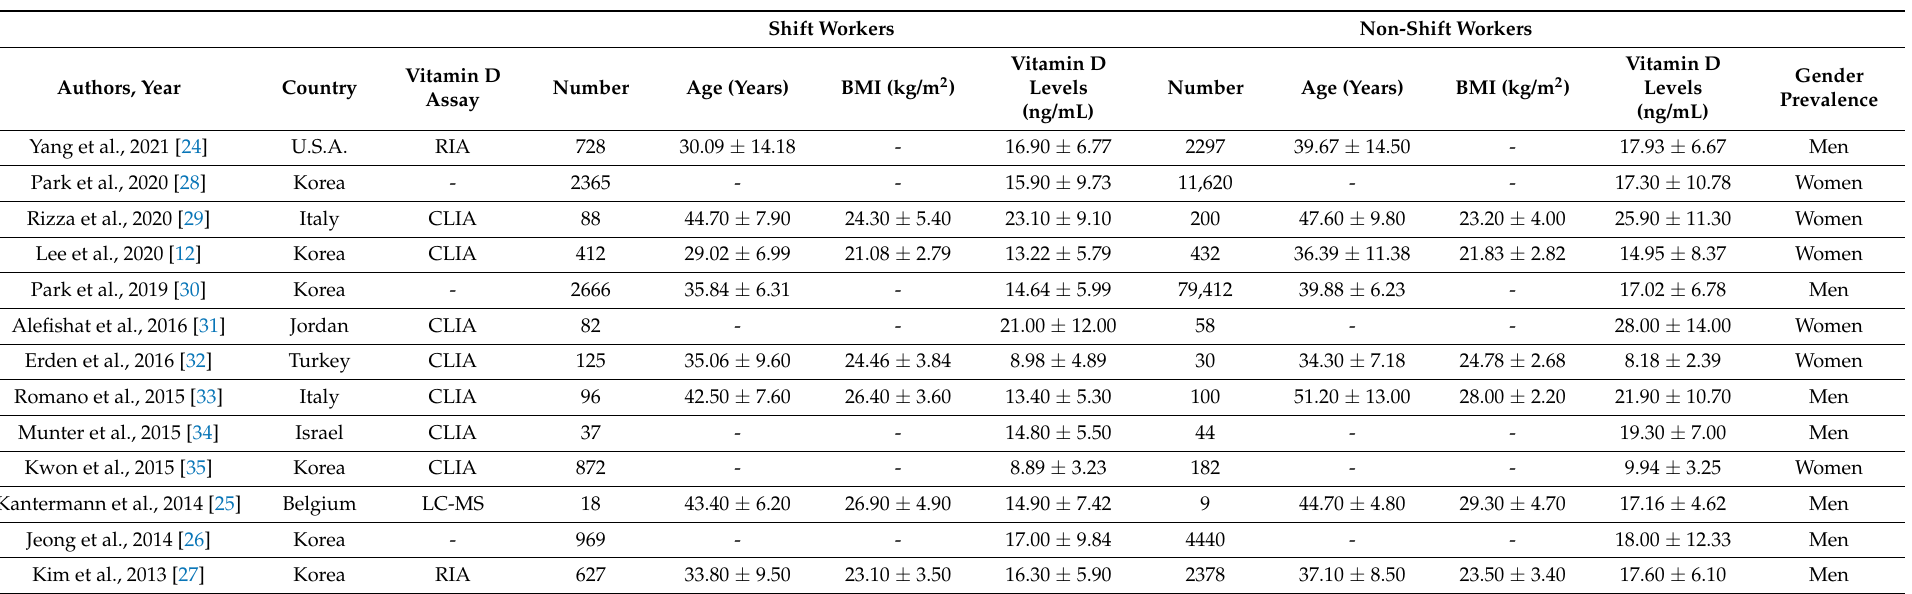
Table 1. Main characteristics of the included